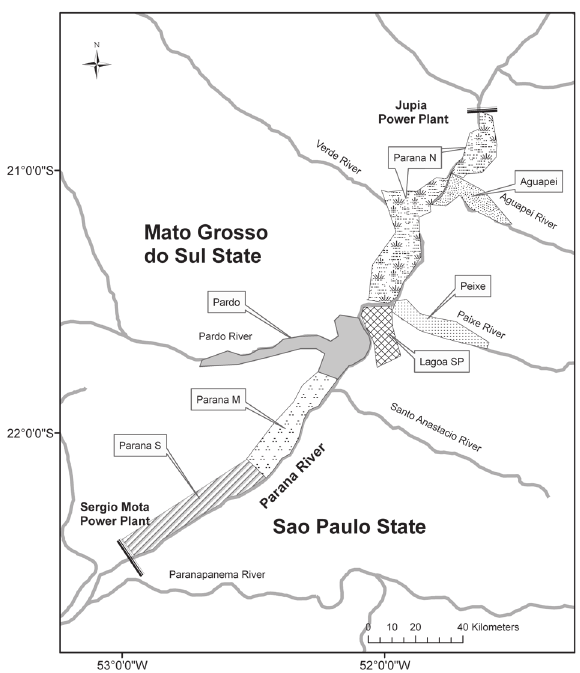
Peixe, Lagoa SP, Paraná N, Pardo, Paraná M and Paraná